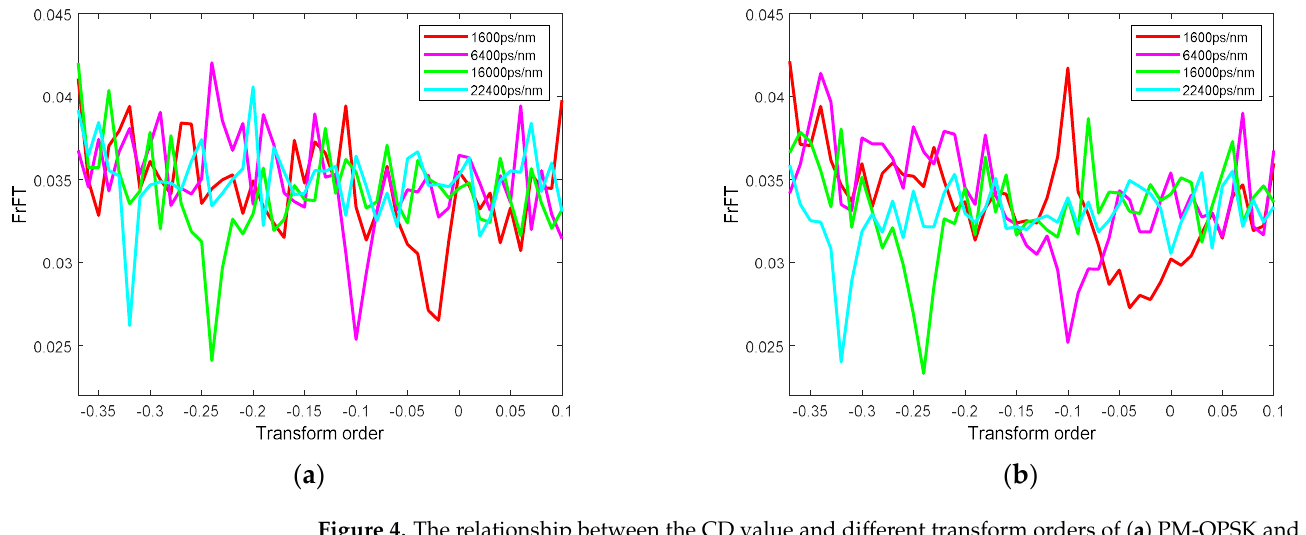
Figure 4. The relationship between the CD value and different transform orders of ( a ) PM-QPSK and ( b ) PM-16QAM signals under FrFT.